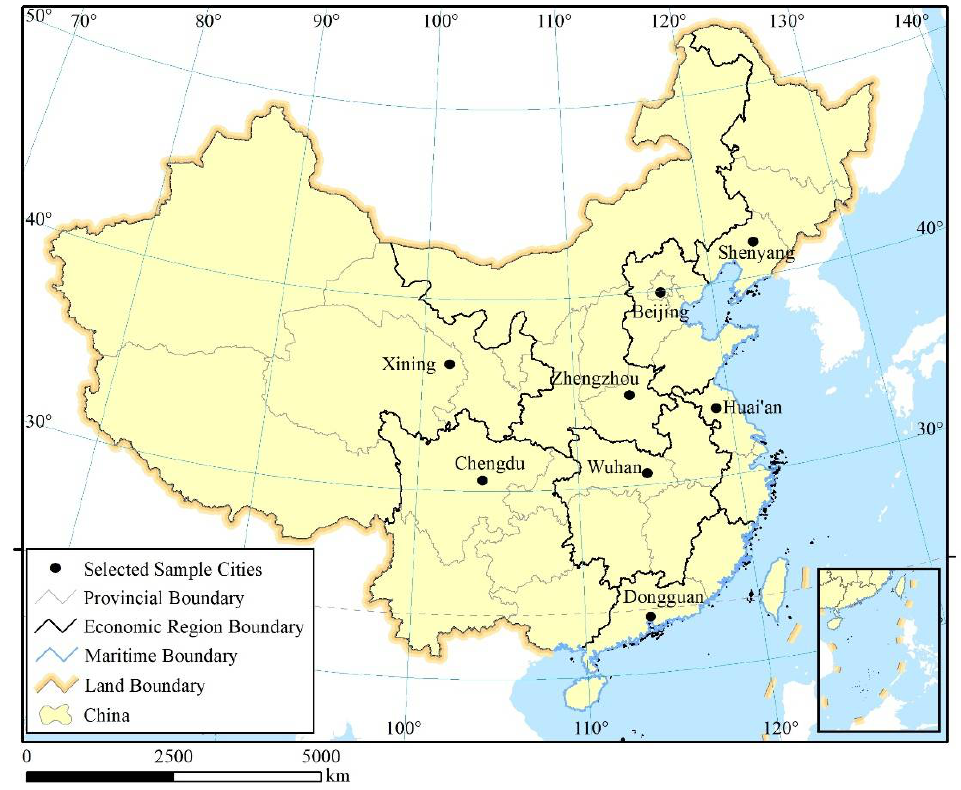
Figure 5. The selected sample cities.